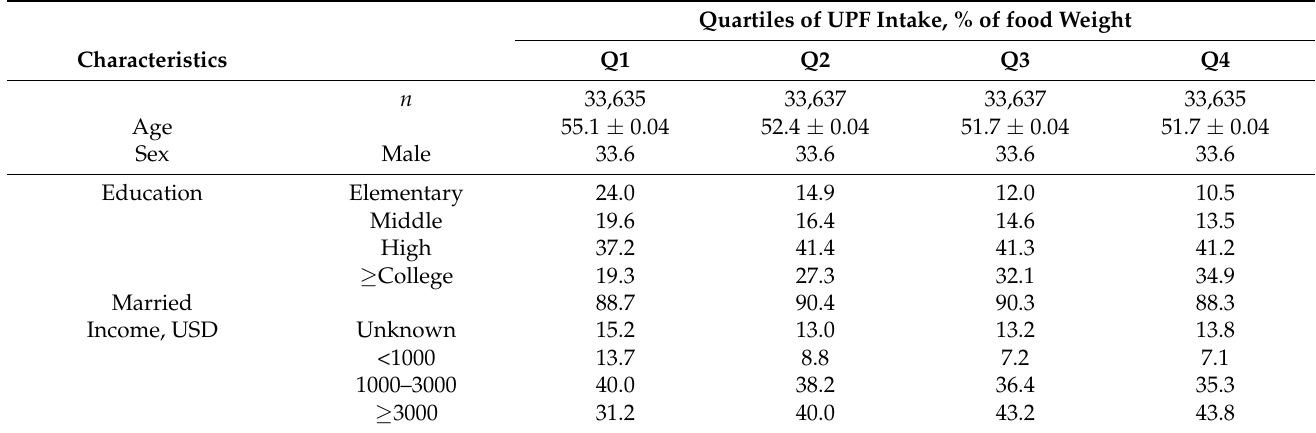
Table 1. Baseline characteristics of study participants by quartiles of UPF